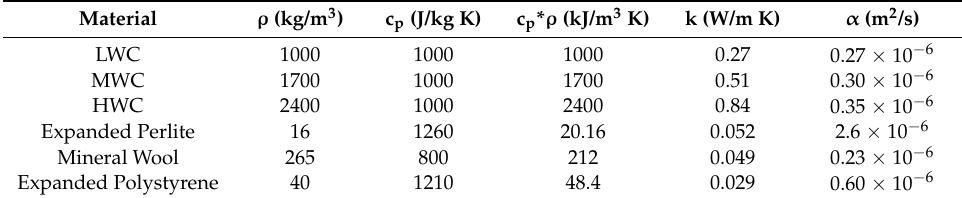
Table 2. Properties of masonry and insulation materials. LWC: light weight clay; MWC: medium weight clay; HWC: heavy weight clay.